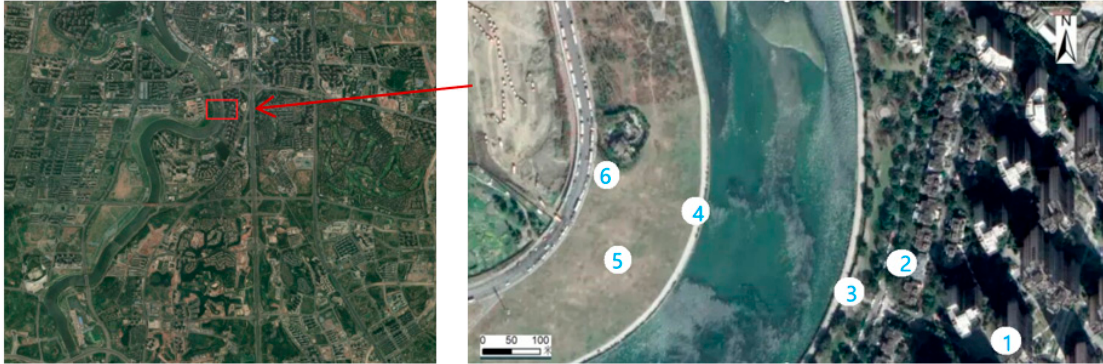
Figure 1. Study area.